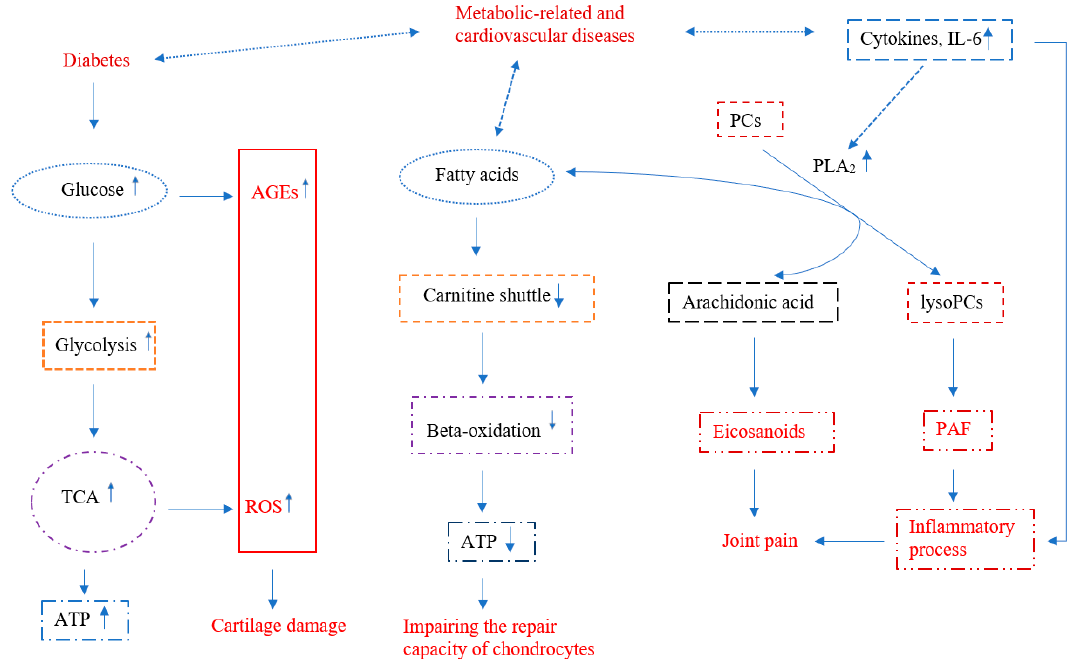
Figure 1. Chart of the metabolic alterations in osteoarthritis (OA) reviewed in this article. Arrows with dash line indicates possible relationships. TCA—tricarboxylic acid cycle; ATP—adenosine triphosphate; PC—phosphatidylcholine; lysoPC—lysophosphatidylcholine; PAF—platelet activating factor; PLA 2 —phospholipase A 2 ; IL ‐ 6—interleukin 6.